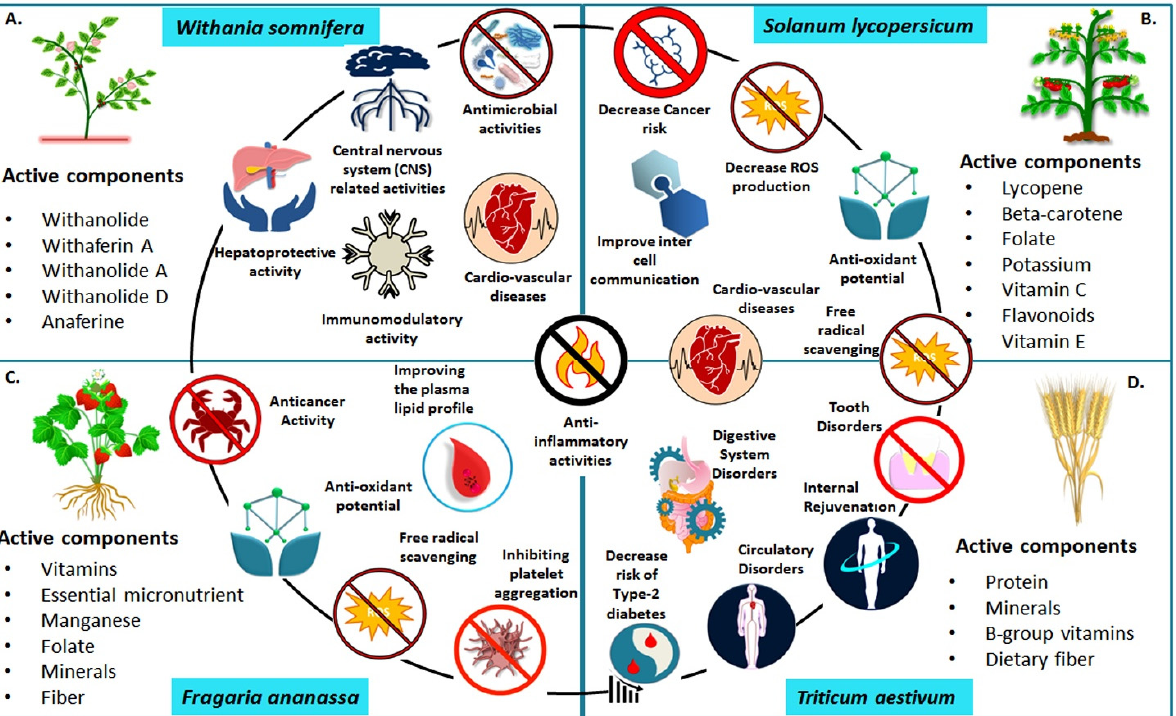
Figure 2. Overview of the nutritional value-addition and health benefits of selected crop plants viz ; ( A ) Ashwagandha ( Withania Somnifera ) ( B ) Tomato ( Solanum lycopersicum ) ( C ) Strawberry ( Fragaria ananassa ) ( D ) Wheat ( Triticum aestivum ).